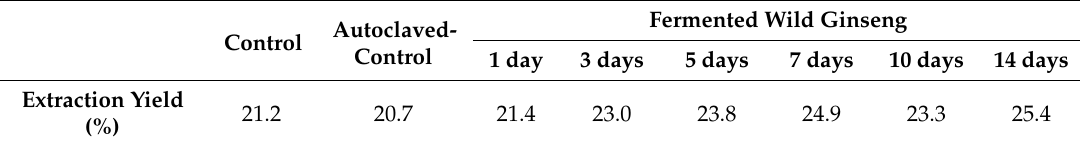
Table 1. Extraction yields of fermented wild